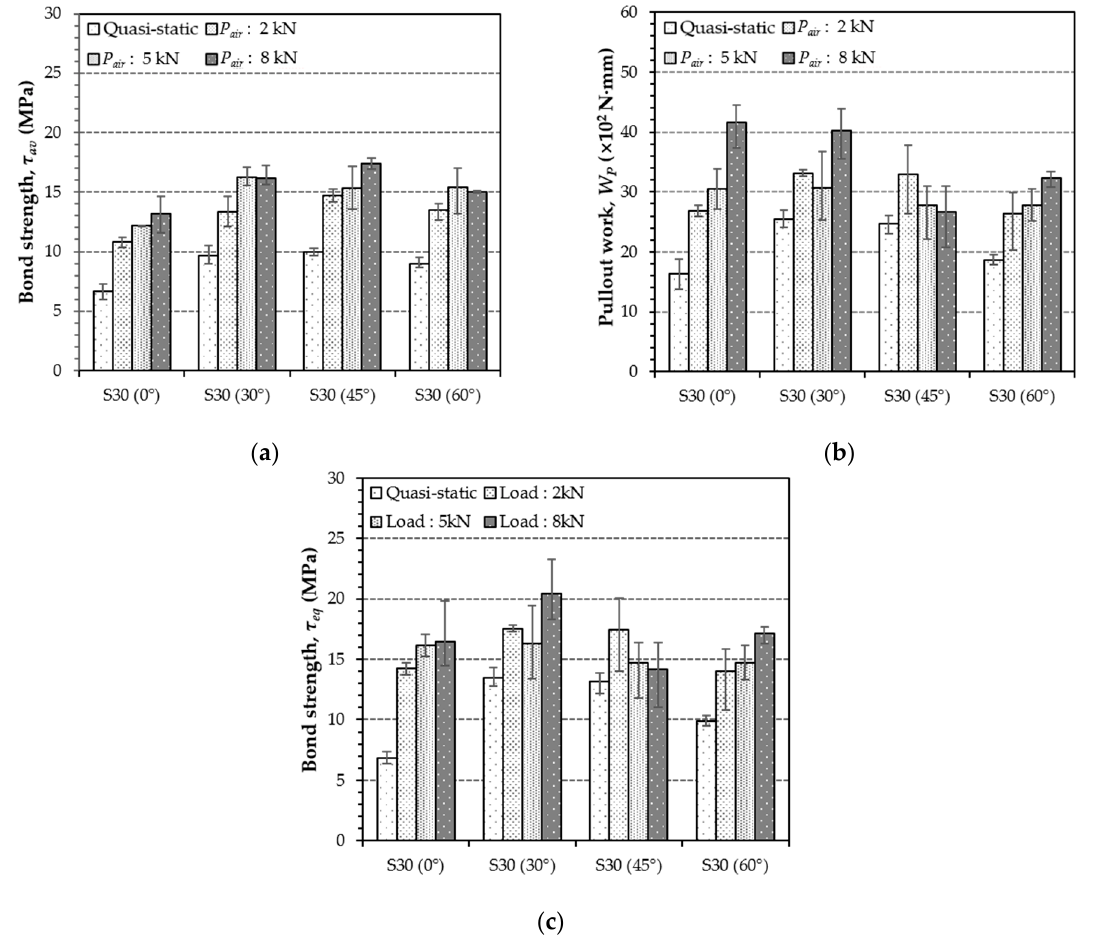
Figure 8. Summary of the effects of inclination angle and loading rate on pullout parameters of S-fiber in ultra-high-performance concrete (UHPC): ( a ) average bond strength, ( b ) pullout work, and ( c ) equivalent bond strength (Note: P air = air pressure).